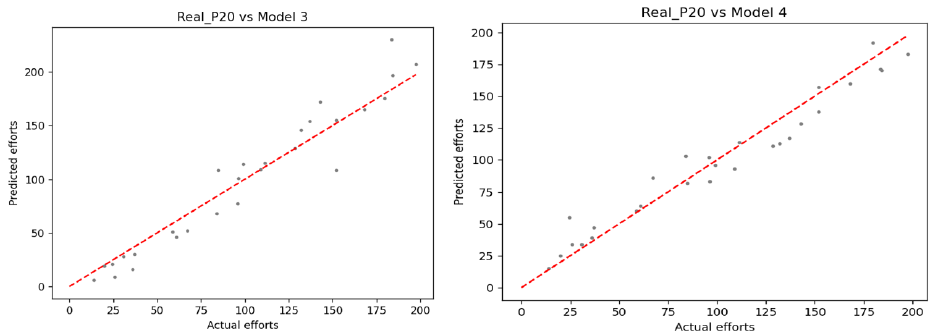
Figure 3. The scatter of predictive efforts vs. actual efforts: Model 3 vs. 4.